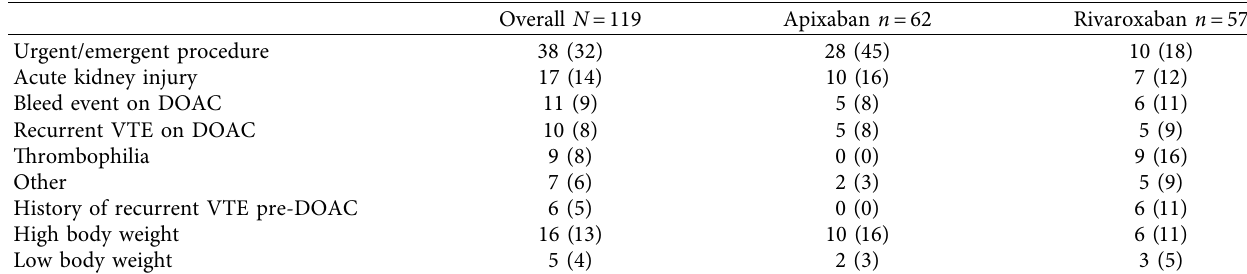
Table 2: Indication for laboratory assessment of DOAC